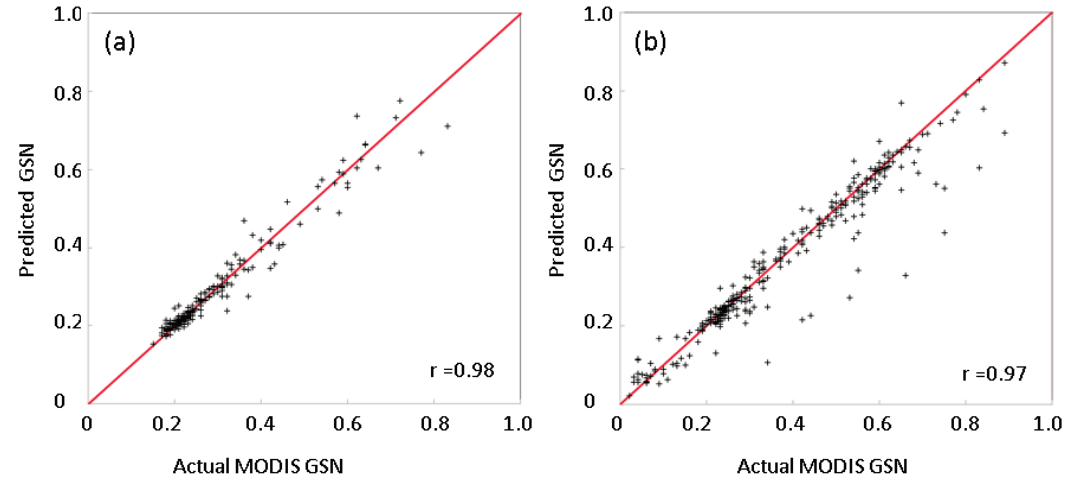
Figure 3. Scatterplots for the actual MODIS GSN and the predicted GSN. ( a ) Clear pixels only; ( b ) Clear and cloudy